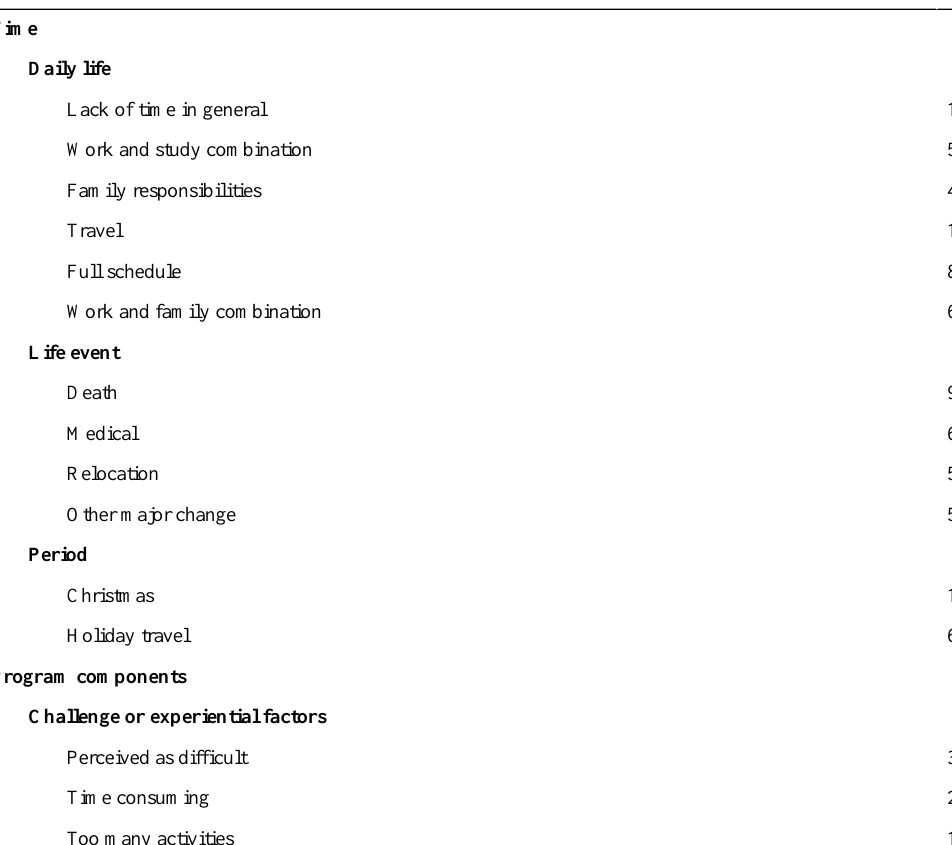
Comments, nThemes, subthemes, and codes or